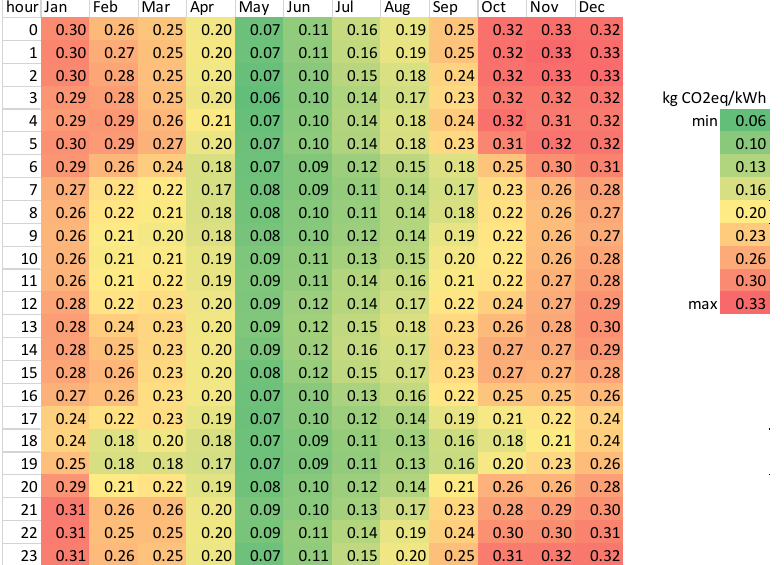
Figure 3. Monthly mean values of CO 2eq coefficients for each hour of the day based on hourly values per year, February–December 2015, January 2016 (green/red color: low/high CO 2eq coefficients).